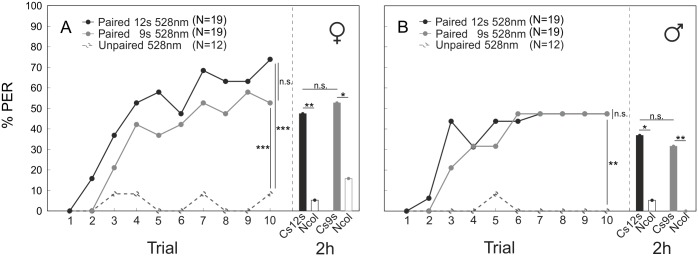
Impact of the conditioning protocol on performance in absolute color conditioning and memory retrieval.Learning curves of (A) workers and (B) drones during absolute conditioning. Bees were trained either with a paired (filled circles) or an unpaired (open circles) presentation of CS and US. Two groups of bees of each sex were trained with different conditioning protocols of the paired CS-US presentation: one group (Paired 12 s) was presented in each trial with 12 s of CS, and 3 s of US 6 s after CS onset, which led to a 3s CS overhang after end of US; a second group (Paired 9s) received 9 s of CS and 3 s of US 6 s after CS onset. In the latter group, CS and US terminated simultaneously. Memory retrieval was tested by presenting the CS and a novel color stimulus (NCol) to the bees 2h after end of conditioning. A, Paired 12 s/Unpaired: MWU, p<0.001, Z = -3.587; Paired 9 s/Unpaired: MWU, p<0.001, Z = 3.587; CS12 s/Ncol: p = 0.003, chi2 = 8.686; CS9 s/Ncol: p = 0.017, chi2 = 5.729). B, Paired 12 s/Unpaired: MWU, p = 0.009, Z = -2.612; Paired 9 s/Unpaired: MWU, p = 0.009, Z = 2.612; CS12 s/Ncol: p = 0.017, chi2 = 5.700; CS9 s/Ncol: p = 0.008, chi2 = 7.125). *** P < 0.001; ** P < 0.01.